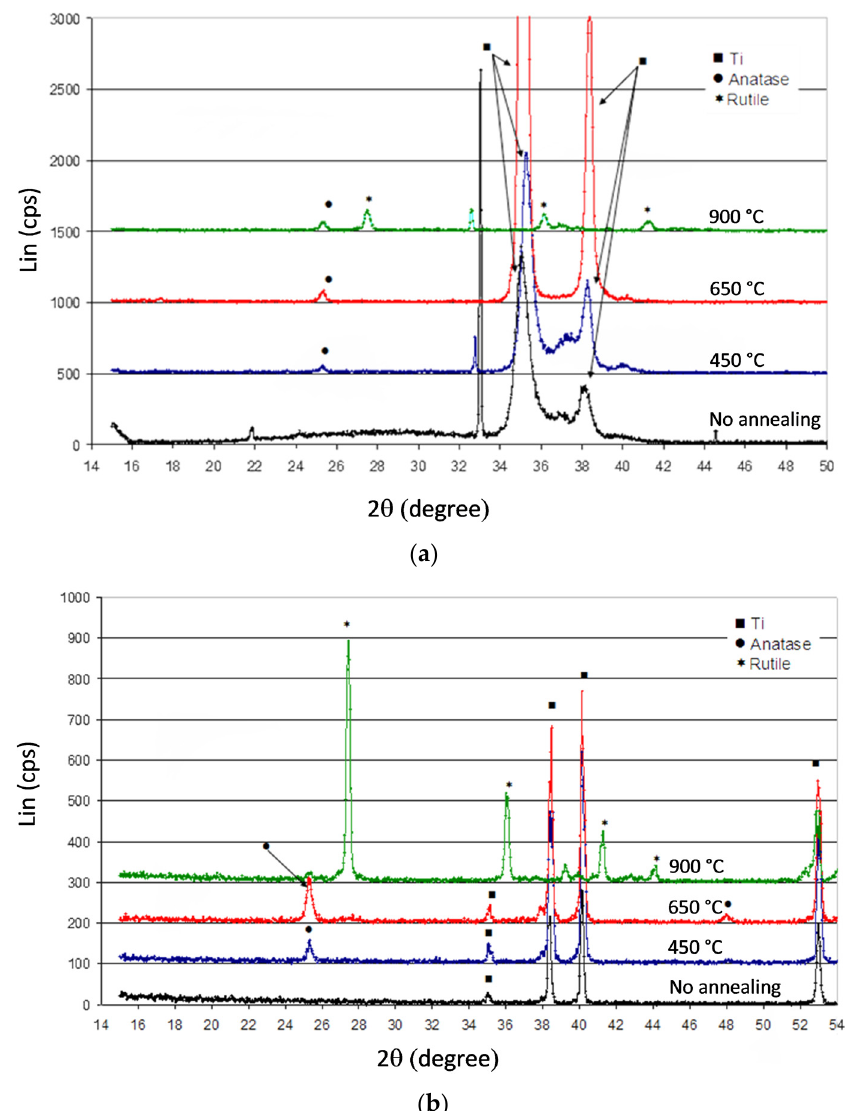
Figure 2. XRD Diagrams obtained in grazing incidence: ( a ) Ti deposed on Si; ( b ) Ti